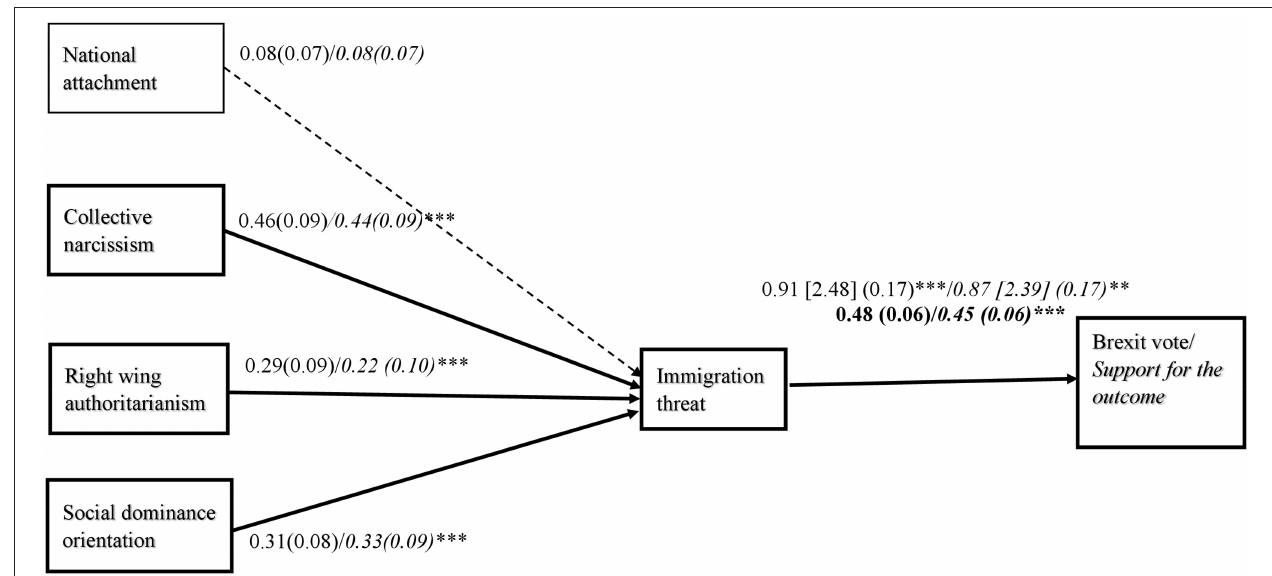
FIGURE 2 | Relationship between variables in Study 2. Coefficients for the binary outcome variable represent log odds [odd ratios] and standard errors are in parentheses. Coefficients for the continuous variables represent unstandardized regression weights. Numerals in italic font correspond to analyses with covariates (national identification, age, gender, education, ethnicity, and indicated national group). Numerals in bold font correspond to unstandardized regression weights and standard error in analyses predicting the continuous support for the outcome of the referendum. *** p < 0.001; ** p < 0.01.